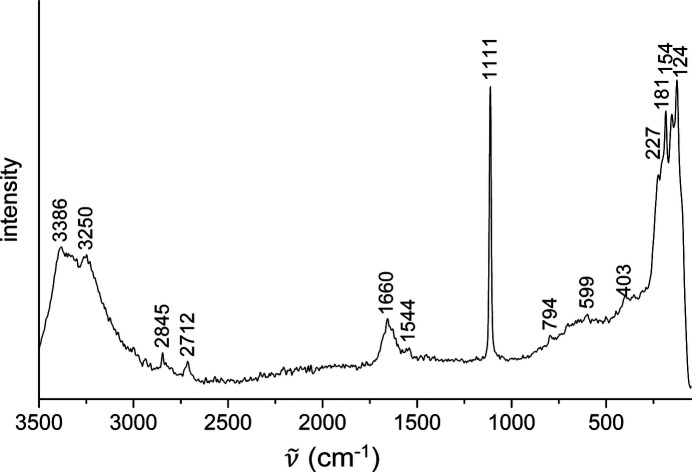
Raman spectrum of MgCO3·MgCl2·7H2O under ambient conditions.